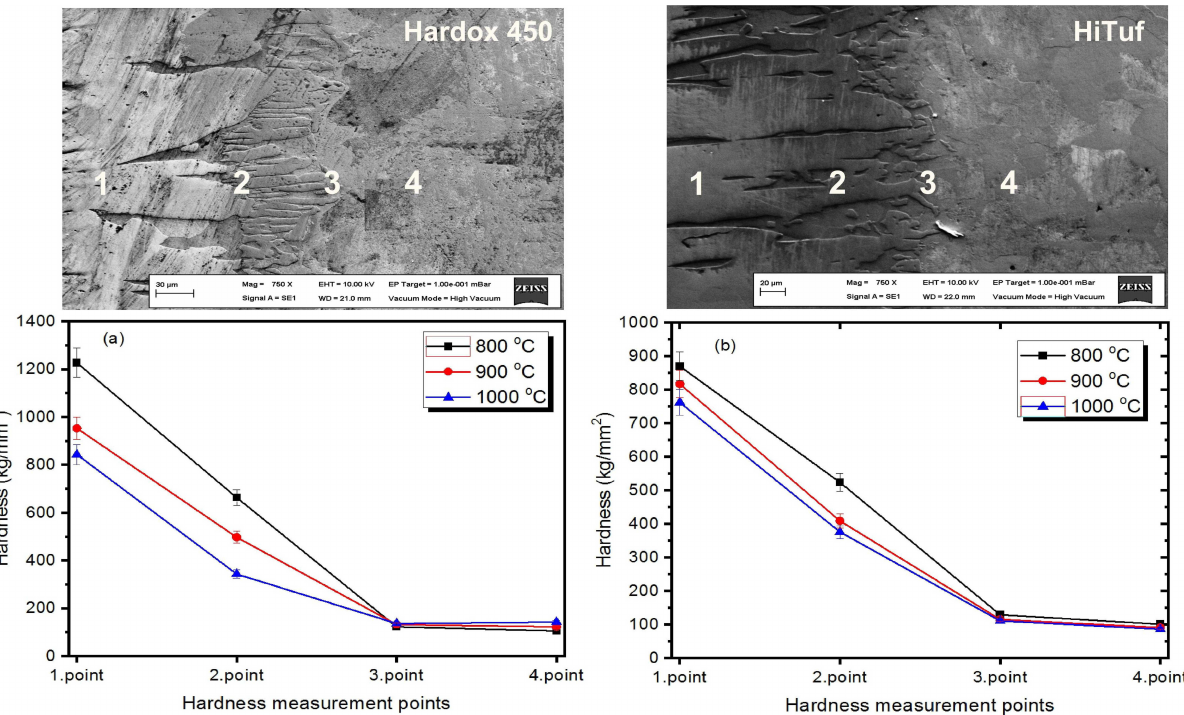
Figure 5: The change of hardness in the borided zones of the samples; (a) Hardox 450, and (b) HiTuf